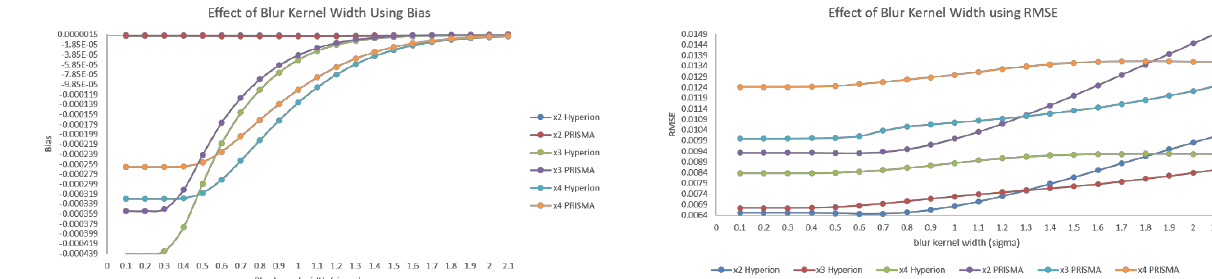
Figure 10. Effect of Blur Kernel Width Using Bias on IBP’s Performance